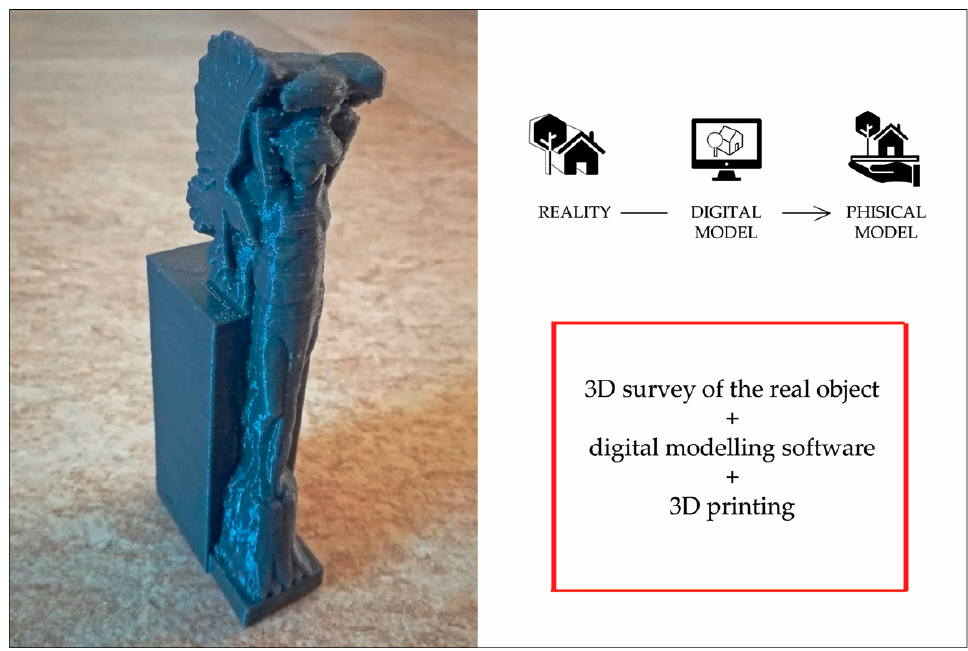
Figure 9. The physical 3D model allows widening the visual and tactile experience of the